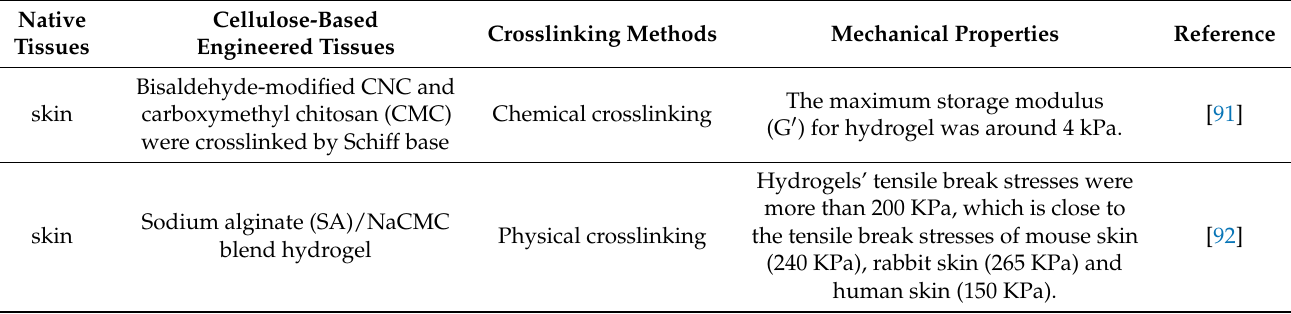
Table 2. Comparison of the mechanical properties of native tissues (skin, bone and cartilage) and cellulose-based engineered